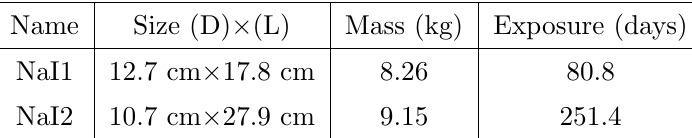
Table 1 . The crystals used in this analysis and the amount of data for each